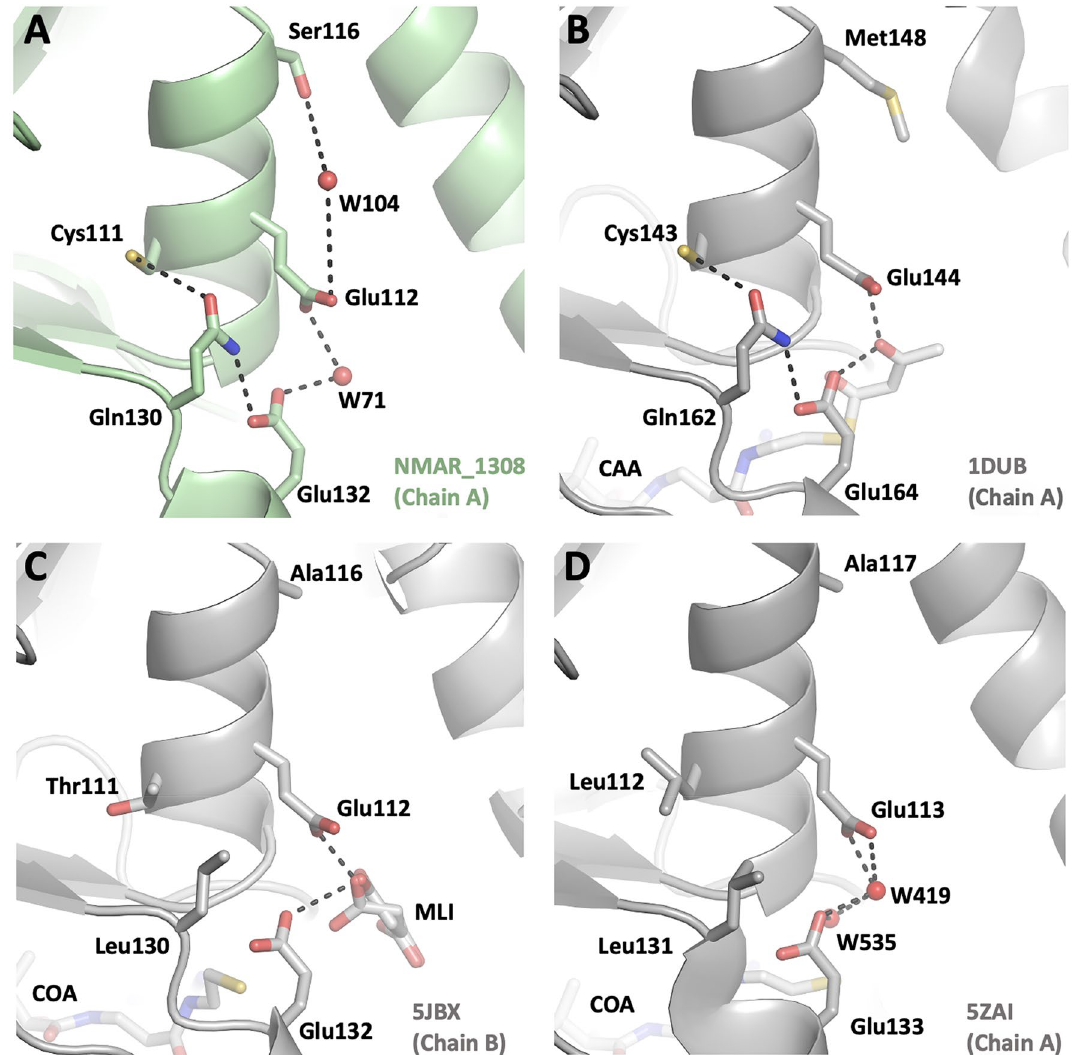
Figure 6. Representation of the potential interaction network of Nmar_1308 based hydratase/dehydrate structures. ( A ) Chain A of Nmar_1308 is indicated with a close look to detect the interaction partners during hydratase/dehydrates reaction. Chain A of Nmar_1308 is colored in pale green. ( B ) The hydratase structure from Rattus norvegicus (PDB ID: 1DUB) is colored in light gray. ( C ) The dehydratase structure from Myxococcus xanthus (PDB ID: 5JBX) is colored in light gray. Malonate (MLI) which may act as a water molecule by forming hydrogen bonds with two catalytic residues (Glu132 and Glu112) in the ligand bound structure is presented with sticks in the panel C. ( D ) The bifunctional enzyme from Metallosphaera sedula (PDB ID: 5ZAI) which has both hydratase and dehydratase activity is colored in light gray. The figure is generated by PyMOL (www. schro dinger. com/ pymol).